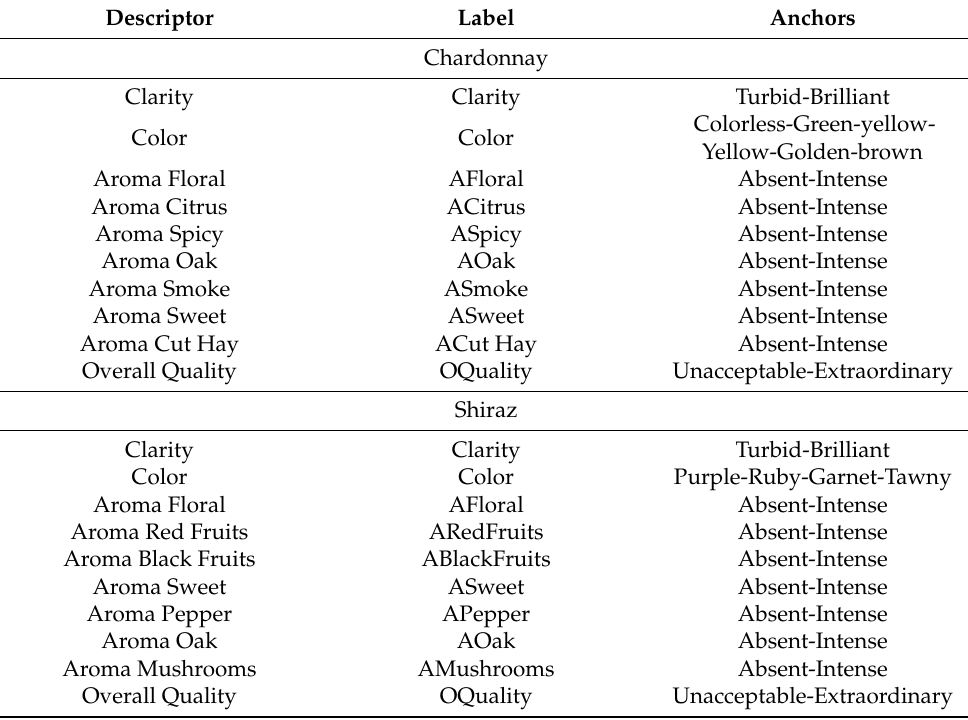
Table 1. Descriptors presented in the descriptive sensory questionnaire for wine samples of Chardon- nay and Shiraz